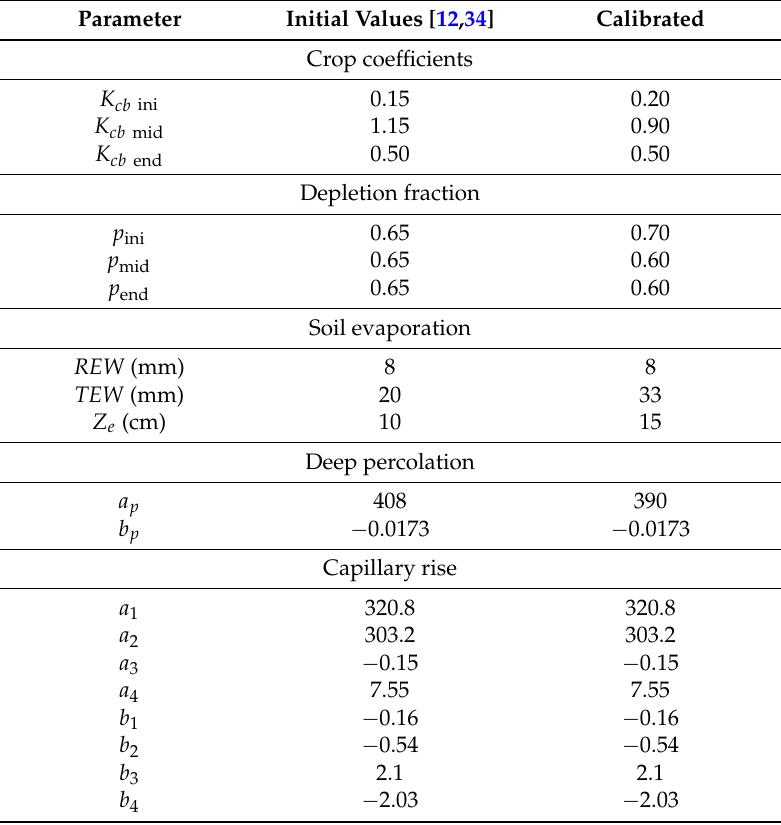
Table 4. The initial and calibrated values of the crop and soil parameters of the growth stage. Parameter Initial Values